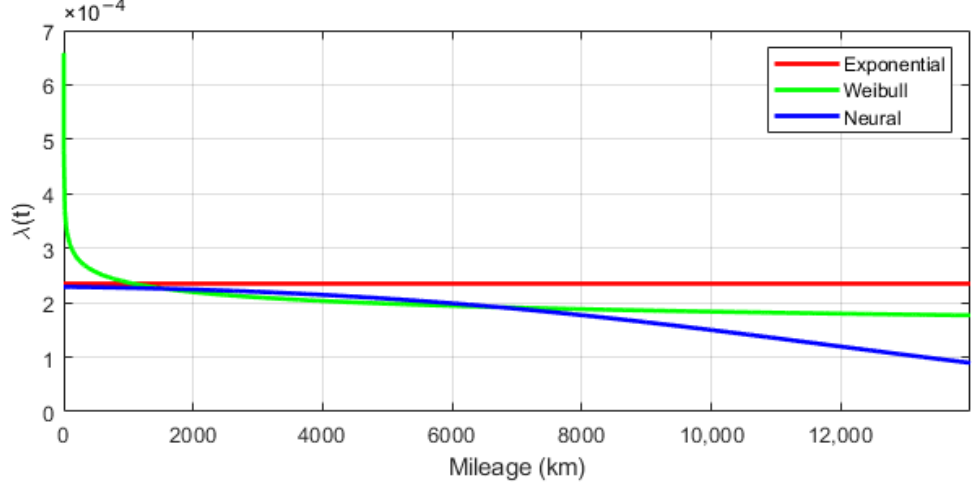
Figure 12. Failure intensity functions of reliability models.